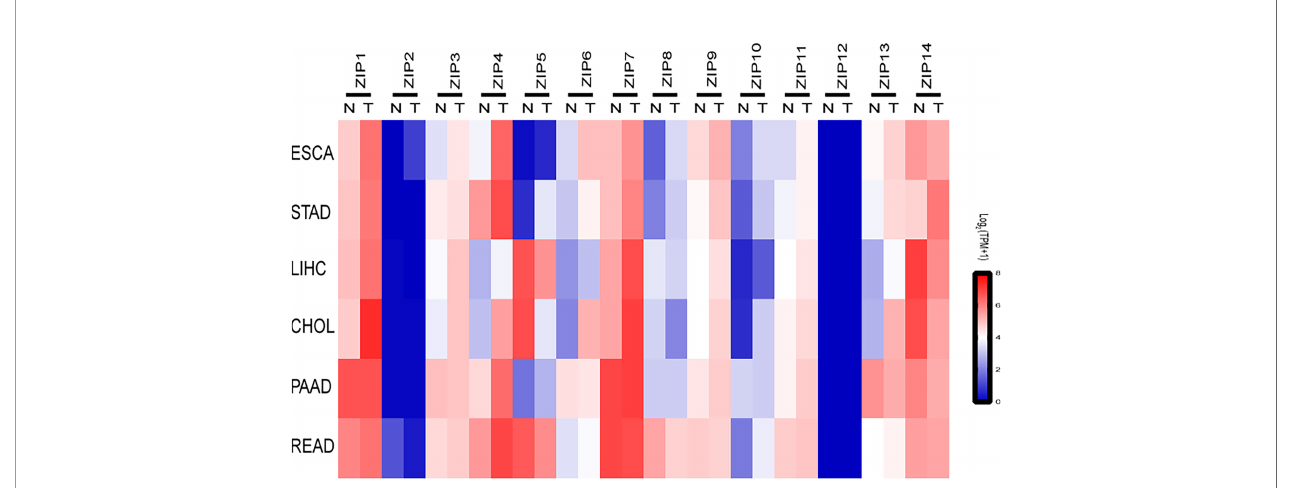
FIGURE 1 | The transcription pro fi les of ZIPs in various cancers of the digestive system. Heat-map depicting the RNA expression pro fi les of ZIPs in a variety of human digestive system cancers based on RNA sequencing data from Gene Expression Pro fi ling Interactive Analysis website (GEPIA2). Data were obtained from cancer patients (T) and healthy controls (N), and each sample was normalized by log 2 (TPM+1). The red and blue regions represent the higher and the lower expression levels, respectively (TPM, transcripts per million; ESCA, Esophageal carcinoma; STAD, Stomach adenocarcinoma; LIHC, liver hepatocellular carcinoma; CHOL, Cholangiocarcinoma; PAAD, Pancreatic adenocarcinoma; READ, Rectum